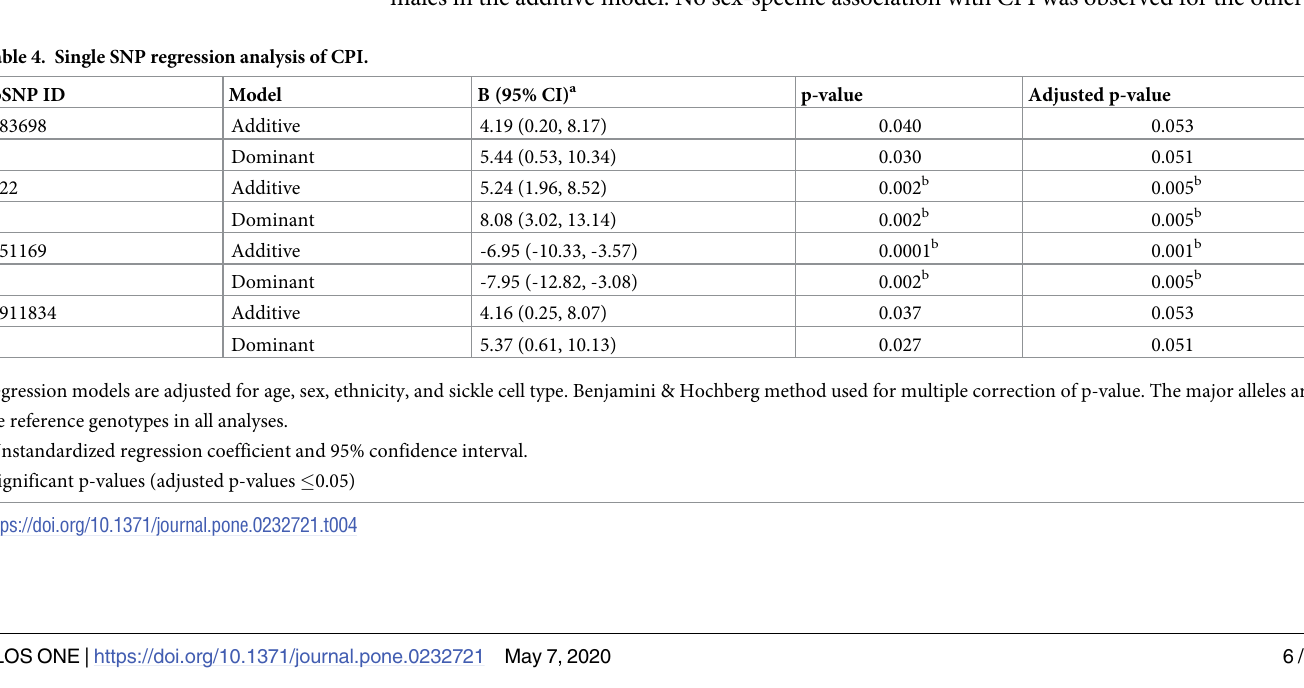
We also found that the T allele of rs9983698 showed trend for association with higher CPI (B = 4.19, p = 0.040, adjusted p = 0.053) in the additive model and the dominant model (B = 5.44, p = 0.030, adjusted p = 0.051). The T allele for rs11911834 exhibited trend for associ- ating with an increase in CPI by 4.16 (p = 0.037, adjusted p = 0.053) and TT and GT genotype combined with an increase of 5.37 (p = 0.027, adjusted p = 0.051). Utilization single SNP regression analysis Regression analyses using SNP effects on utilization data showed association only for rs1051169 (Table 5). The G allele of rs1051169 was associated with decreased utilization in the additive (IRR = 0.75, p = 0.031) model at a nominal level. However, adjusted p-value did not reach statistical significance. None of the models (additive and dominant) were significant for rs9983698, rs9722 and rs11911834.